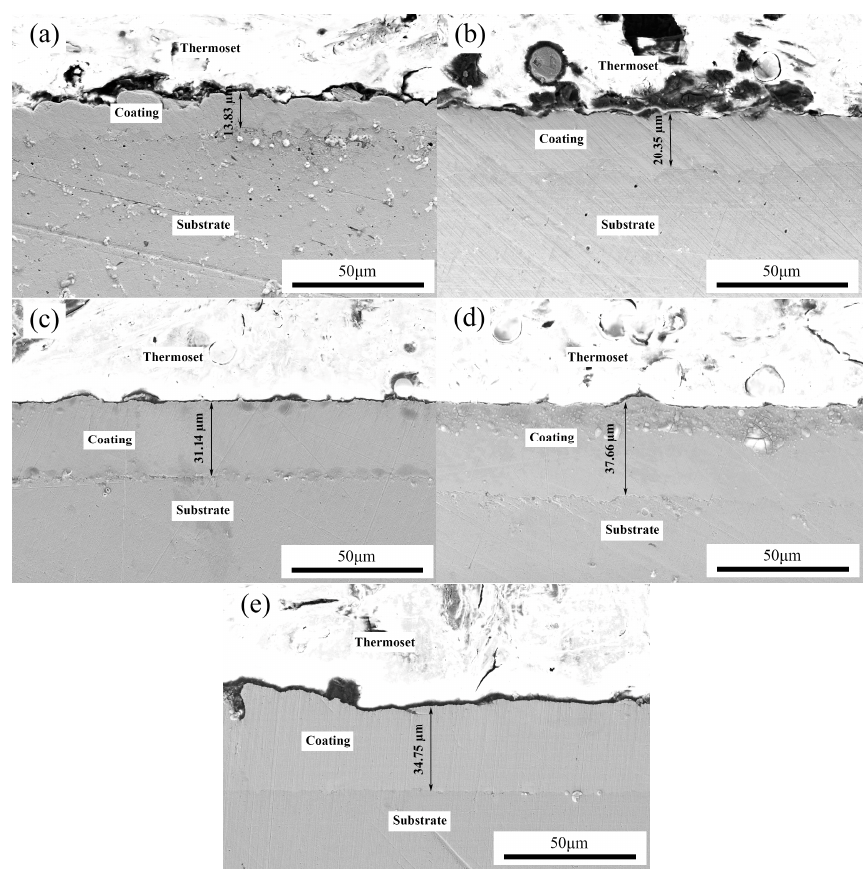
Figure 4. Cross-section images of the Ni–Co–BN (h) nanocomposite coatings with pulse frequency of 4 kHz and varying duty cycles: ( a ) 0.1, ( b ) 0.3, ( c ) 0.5, ( d ) 0.7, ( e ) 0.9.